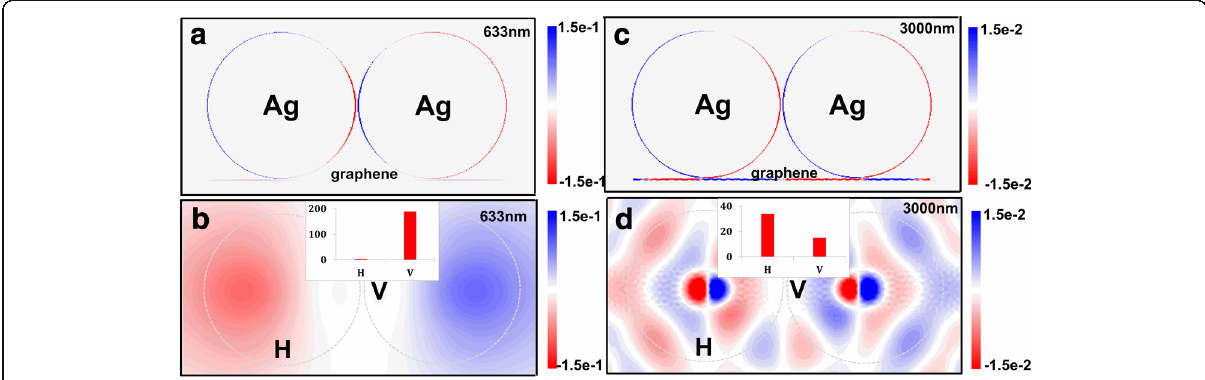
Fig. 2 Surface charge redistribution in nanoparticle/graphene hybrid system. Surface charge distributions of R = 50 nm Ag nanoparticle dimer on monolayer graphene with 1-nm gap a at 633 nm and c at 3000 nm. Surface charge distributions in graphene surface of R =50 nm Ag nanoparticle dimer on monolayer graphene with 1-nm gap b at 633 nm and d at 3000 nm. The deduced charge dipole interaction representation at 633 and 3000 nm is shown on the right of Fig.